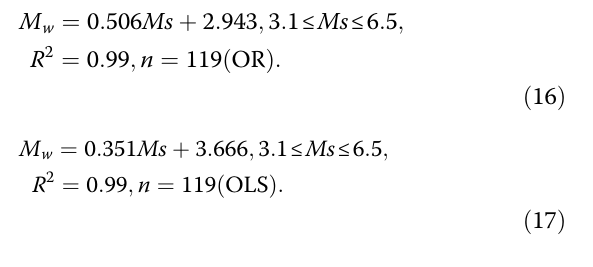
ffiffiffiffiffiffiffiffiffiffiffiffiffiffiffiffiffiffiffiffiffiffiffiffiffiffiffiffiffi